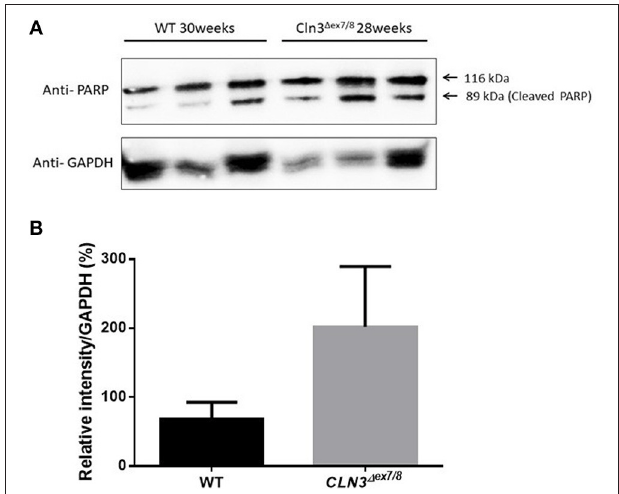
FIGURE 7 | Quantification of apoptosis as determined with PARP cleavage by Western blot of WT and Cln3 ∆ ex7/8 mouse brain ( n = 3 in each group). (A) Representative image of Western blot analysis. (B) Mean relative intensity quantification of three independent experiments. There is an increase in apoptosis in 28–30 weeks of age Cln3 ∆ ex7/8 compared to age-matched WT mouse